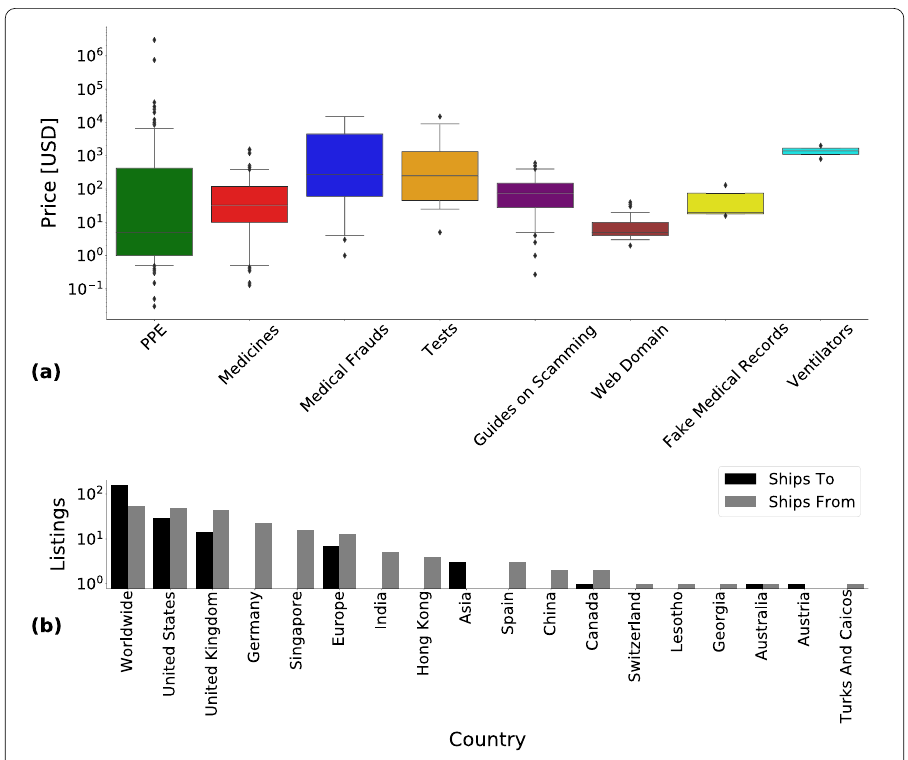
Figure 2 ( a ) Box plot of the distribution of listing prices for each COVID-19 category. The box ranges from the lower to the upper quartile, with the horizontal line indicating the median. The whiskers extend up to the 5th and 95th percentiles respectively. The dots represent outliers. ( b ) Shipping information in COVID-19 specific listings. Note that 545 (or 71.1%) of these listings did not provide any shipping